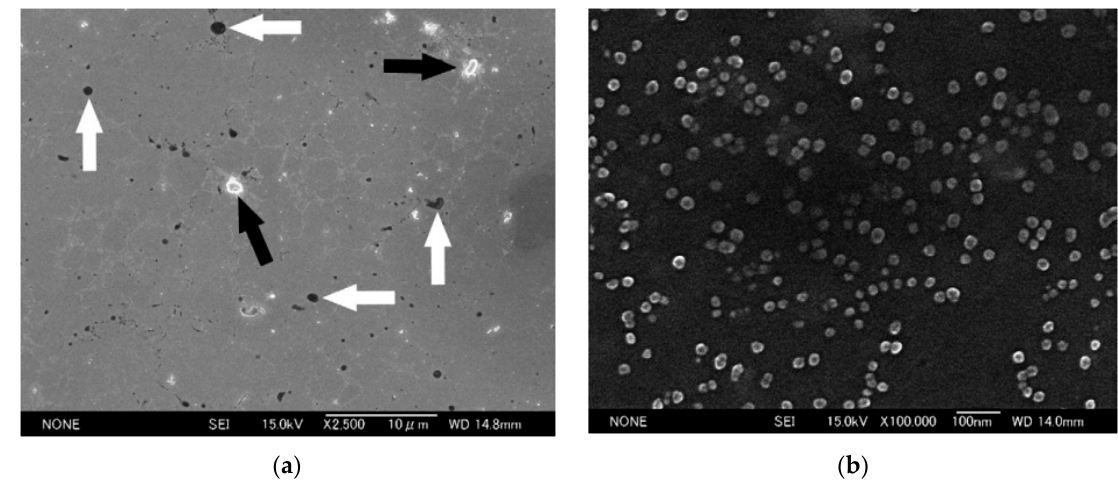
Figure 9. Scanning electron microscopy (SEM) images of EDC samples sintered with 300 MPa and 1.5 kJ/g showing the ferritic matrix and M6C carbides: ( a ) black arrows pointing to large and complex carbides (M 6 C with Fe, W, Cr, Mo and V) of 0.5–1.5 μ m and white arrows pointing to residual pores; ( b ) extremely fine carbides (10–15 nm) homogenously dispersed in the ferritic matrix. Reprinted with permission from ref. [54] Copyright 2008 Elsevier.